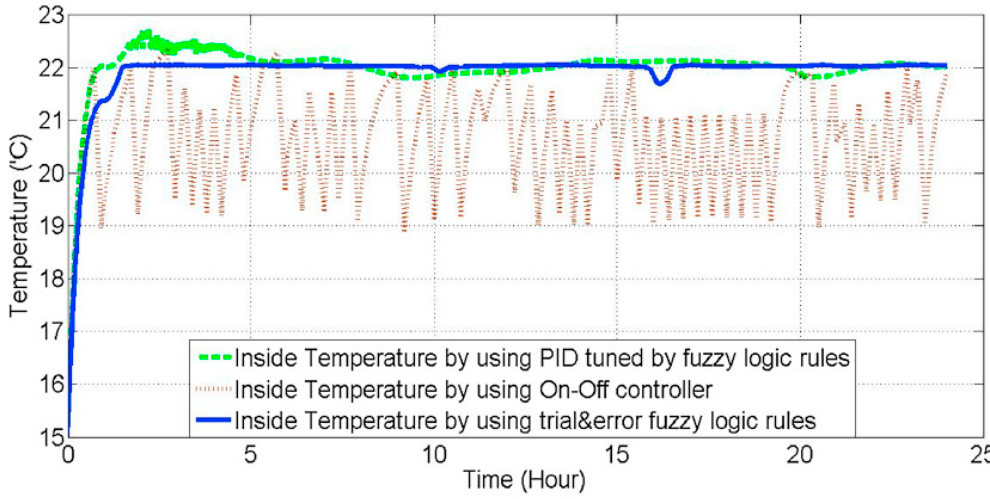
Figure 22. Effect of different control algorithms on indoor comfort temperature in the house integrating PCM reservoir [167].